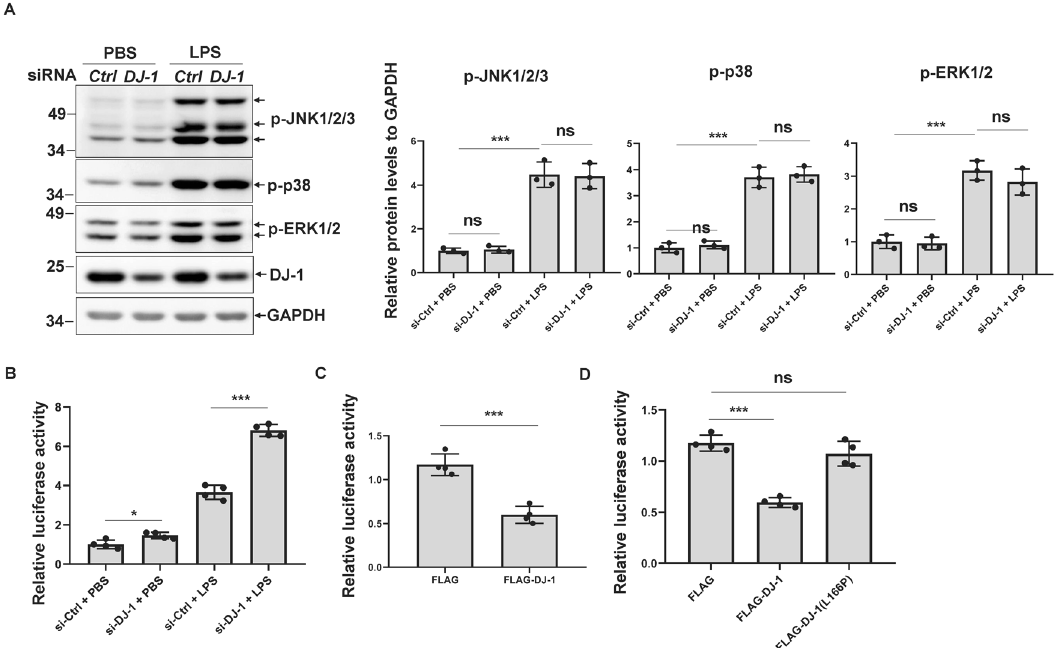
Fig. 3 DJ-1 rather than L166P mutant represses NF- κ B transcriptional activity. A si- Ctrl or si- DJ-1 was transfected into BV2 cells for 72 h. Then the cells were treated with PBS or LPS (100 ng/ml) for 15 min. The cell lysates were analyzed by immunoblotting using the indicated antibodies. The bar graph shows the relative band intensity of p-JNK1/2/3, p-p38, or p-ERK1/2 to that of GAPDH. n = 3. B BV2 cells harboring lentiviral NF- κ B-luc were transfected with si- Ctrl or si- DJ-1 . After 48 h, the cells were treated with PBS or LPS (100 ng/ml) for 24 h and then subjected to a luciferase reporter gene assay. n = 4. C HEK293 cells were transiently transfected with pNF- κ B-luc and Renilla along with FLAG or FLAG-DJ-1. After 48 h, the cells were subjected to a luciferase reporter gene assay. One-way ANOVA, n = 4. D HEK293 cells were transiently transfected with pNF- κ B-luc and Renilla along with FLAG, FLAG-DJ-1, or FLAG-DJ-1(L166P). After 48 h, the cells were subjected to a luciferase reporter gene assay. One-way ANOVA, n =